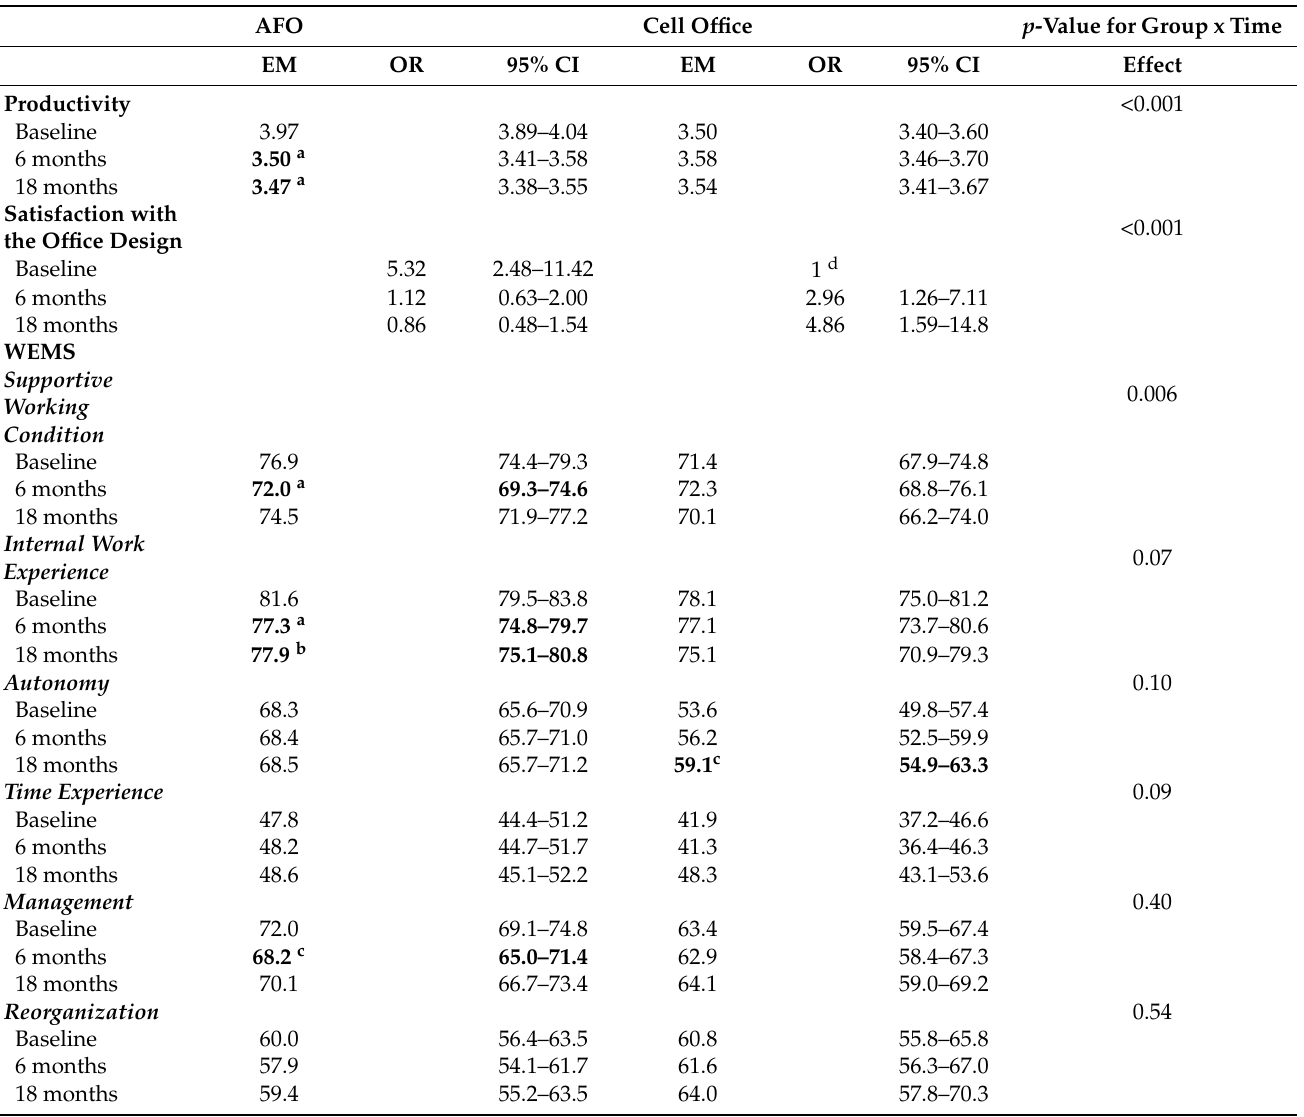
Table 2. Comparisons of perceived productivity, satisfaction and psychosocial working conditions (WEMS, Work Experience Measurement Scale) in the activity-based flex office (AFO) and cell office, expressed as estimated means (EM) and odds ratios (OR). Difference between the groups over time is expressed as group x time effect. For estimated means (EM), pairwise comparisons within groups are presented. Bold indicates statistically significant within group